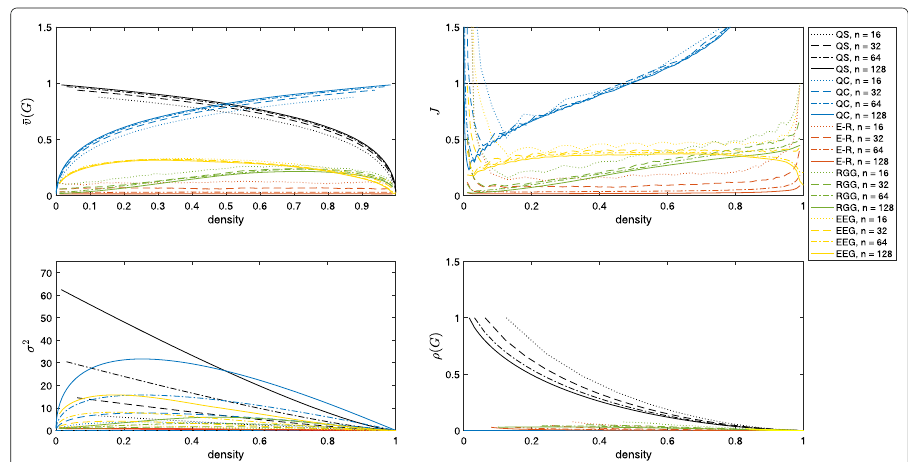
Fig. 2 Normalisations of degree variance of quasi-star graphs (QS), quasi-complete graphs (QC), ER random graphs (E-R), Random Geometric Graphs (RGG) and EEG PLI networks (EEG) of sizes 16 (dotted lines), 32 (dashed lines), 64 (dash-dotted lines) and 128 (solid lines). The proposed normalisation shows smooth curves which are markedly stable with respect to n for all graphs. Clearly, J and σ 2 violate standard normalisation principles and are influenced by network size. On the other hand ρ cannot be computed for graphs with isolated nodes which are particular prominent at lower densities of the weighted models and values are squeezed at high densities